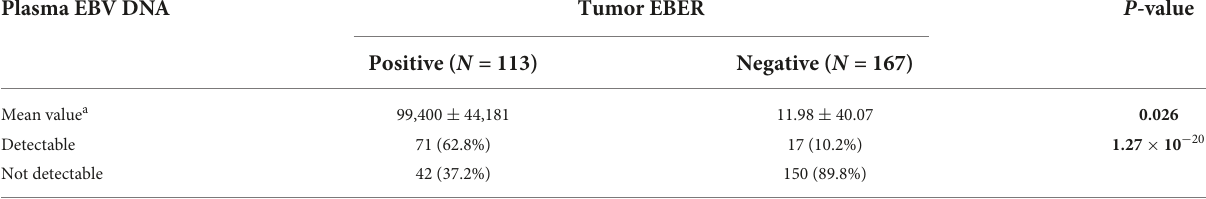
TABLE 2 Association between tumor EBV-encoded small RNA (EBER) and plasma Epstein–Barr virus (EBV) DNA. Plasma EBV DNA